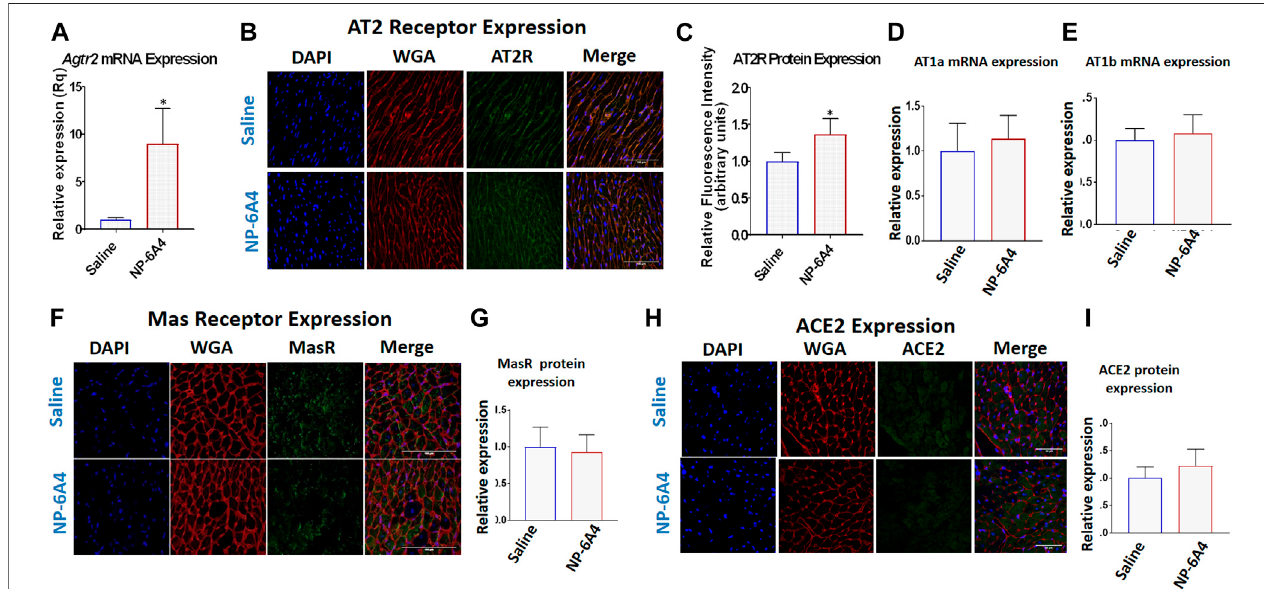
FIGURE 4 | NP-6A4 treatment increased expression of cardiac AT2R, but not AT1 receptor subtypes, Mas receptor or ACE2. (A) Expression of cardiac Agtr2 (AT2R) mRNAasdetermined byqRT-PCRinSaline-and NP-6A4treatedrats. n (cid:1) 6pergroup. (B) .Representativeimages ofheartsectionsfromimmunohistochemistry analysis using anti-AT2R antibody as the probe (green), nuclei visualized by DAPI staining (blue) and cell membranes visualized by staining with WGA-Alexa Fluor 647 (red) ( × 63 magni fi cation, scale bars (cid:1) 50 µm). (C) Graphs show cumulative data for normalized anti-AT2R antibody staining. (D and E) Expression of cardiac AT1 receptor subtypes AT1a and AT1b mRNA expression as determined by qRT-PCR. (F and H) Representative images of heart sections from immunohistochemistry analysis using anti-MasR antibody or anti-ACE2 antibody as the probe (green), nuclei visualized by DAPI staining (blue) and cell membranes visualized by staining with WGA-Alexa Fluor 647 (red). (G and I) Graphs show cumulative data for normalized anti-MasR antibody and anti-ACE2 antibody